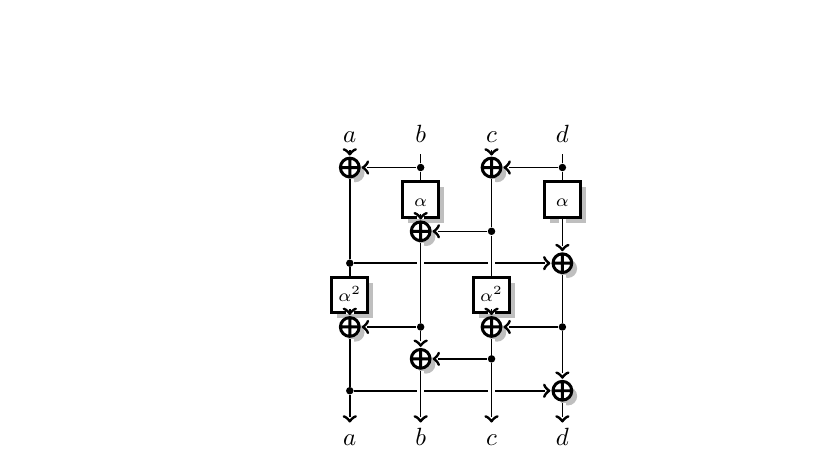
Figure 3: A 4-bit MDS mapping from [DL18]. The input/output ( 𝑎, 𝑏, 𝑐, 𝑑 ) corresponds to nibbles with index (4 𝑖, 4 𝑖 + 1 , 4 𝑖 + 2 , 4 𝑖 + 3), for 0 ≤ 𝑖 ≤ 15.